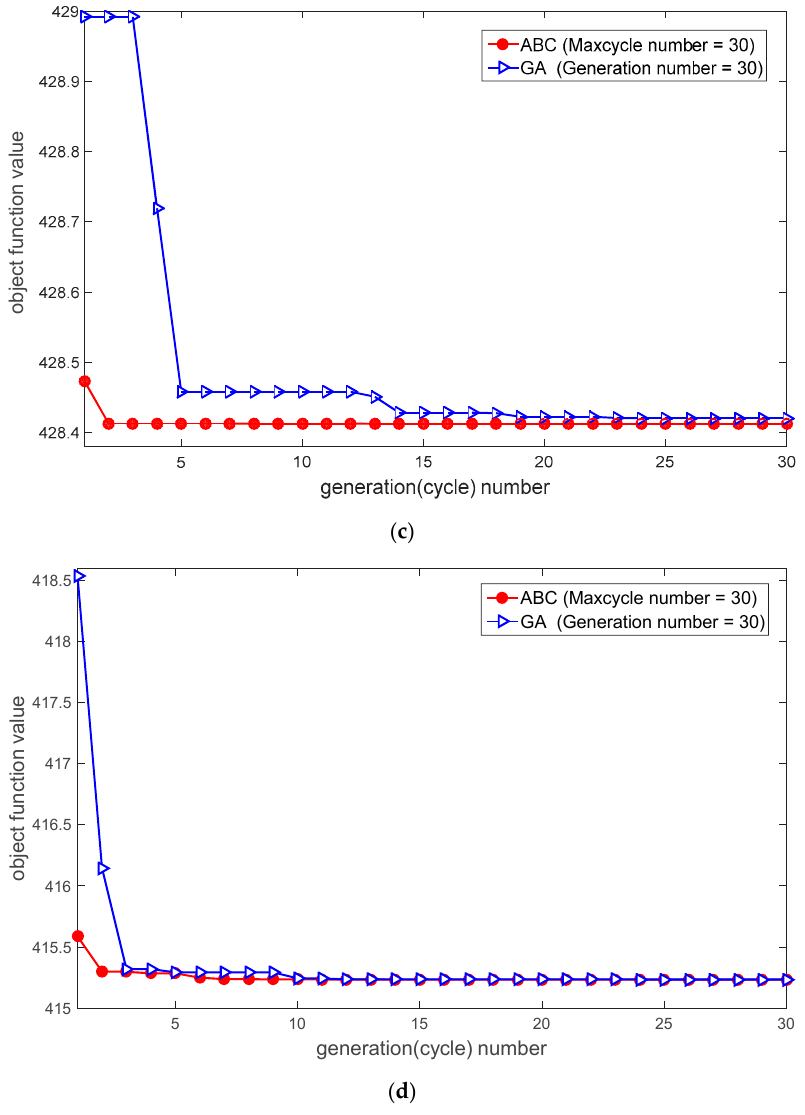
Figure 9. Convergence graph of the best objective function value in different error models: ( a ) The radius of scatters of 200 m on the CDSM error model ( b ) The radius of scatters of 400 m on the CDSM error model ( c ) The upper bound of 300 m of NLOS range error ( d ) The upper bound of 500 m of NLOS range error. Table 3. Average convergence cycles/generations and the location execution time.